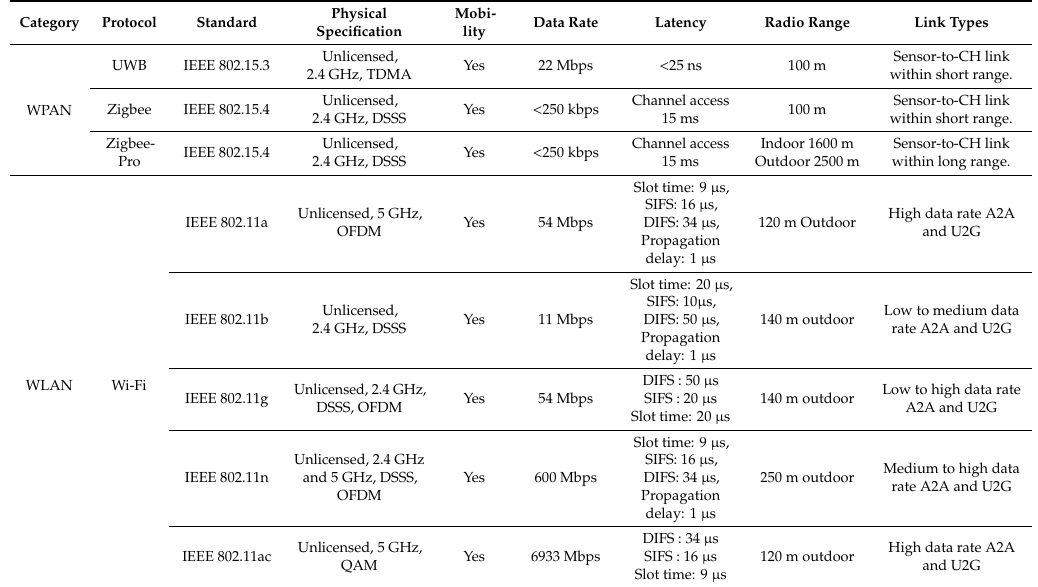
Table 1. Comparison of communication technologies for unmanned aerial vehicle (UAV)-aided wireless sensor networks